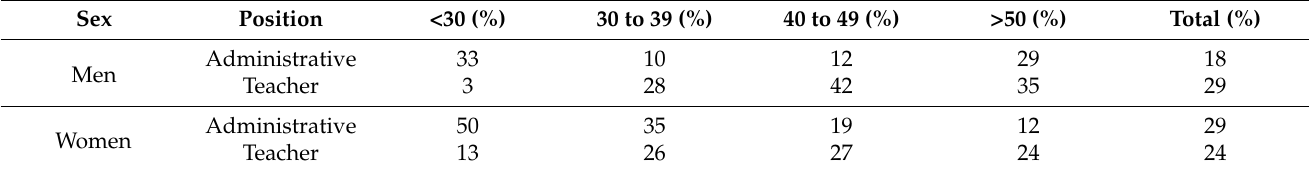
Table 1. Percentage distribution of participants according to sex, age and job